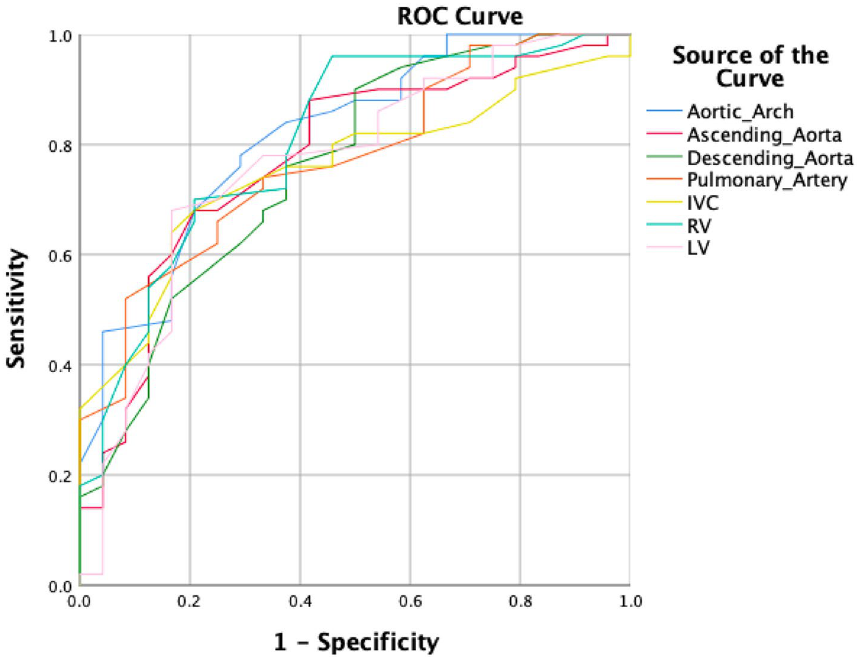
Figure 2. Results obtained using receiver operating characteristic (ROC) analysis. The area under the curve was 0.816 for the aortic arch, the highest among the other anatomic locations of blood attenuation measurement. IVC inferior vena cava, RV right ventricle, LV left